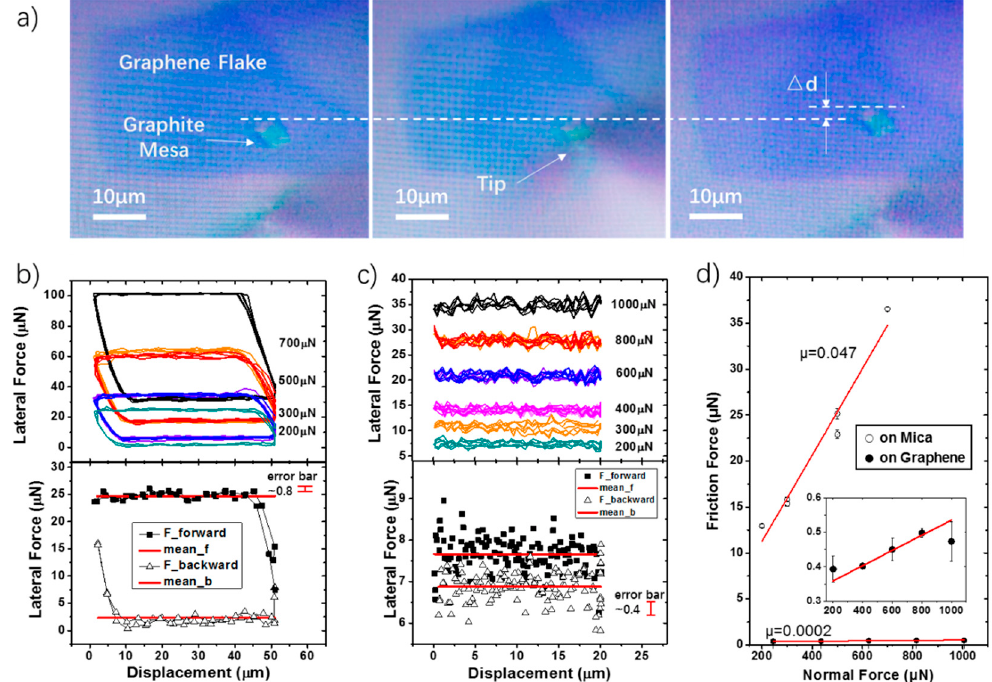
Figure 8. Friction experiments. ( a ) Photos observed by the optical microscope. The shoe-like shape in a dark purple color is the graphene flake; the blue square pointed out by an arrow is the 5 µ m × 5 µ m graphite mesa, the tip is shown in a bright triangle shape at the bottom of each photo. A small sliding distance of the graphite mesa can be observed after applying a load on it by the tip; ( b ) friction loops of the graphite-mica interface using the #3 teeter-totter beam; ( c ) friction loops of the graphite-graphene interface using the #5 teeter-totter beam. ( b , c ) The picture at the bottom shows a magnified friction loop under the smallest normal load in each case. Points labeled in black squares and white triangles represent signals of di ff erent moving directions. The red thick line is the average lateral force in each direction; ( d ) relationships between the normal forces and the friction forces. The insert diagram is a magnification of the graphite-graphene